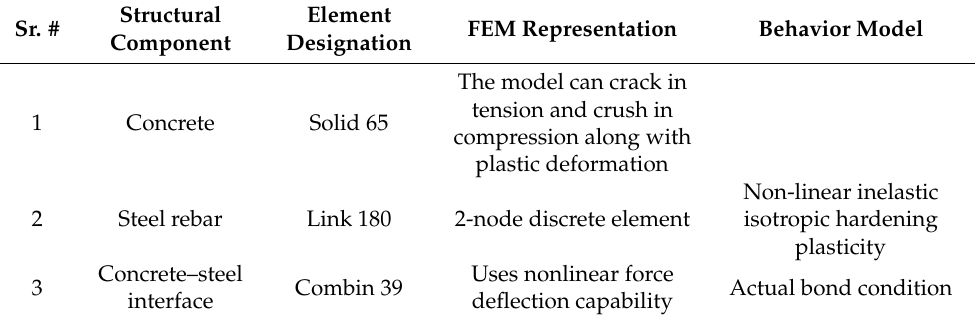
Table 7. Element properties and behavior. Sr.